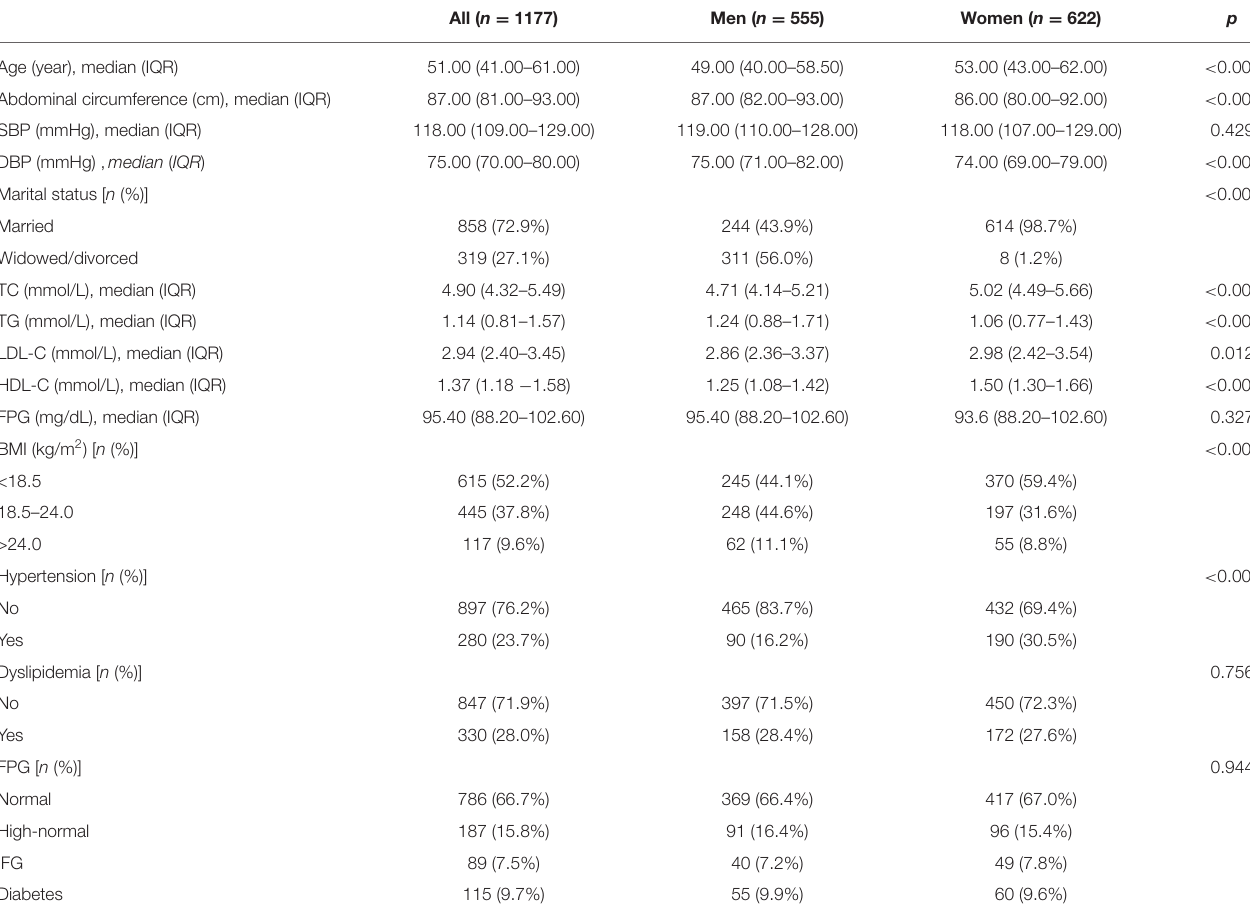
TABLE 1 | Baseline characteristics of